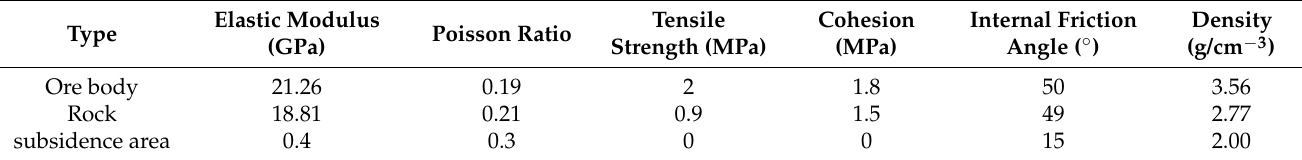
Table 1. Key experimental parameters of ore deposit.